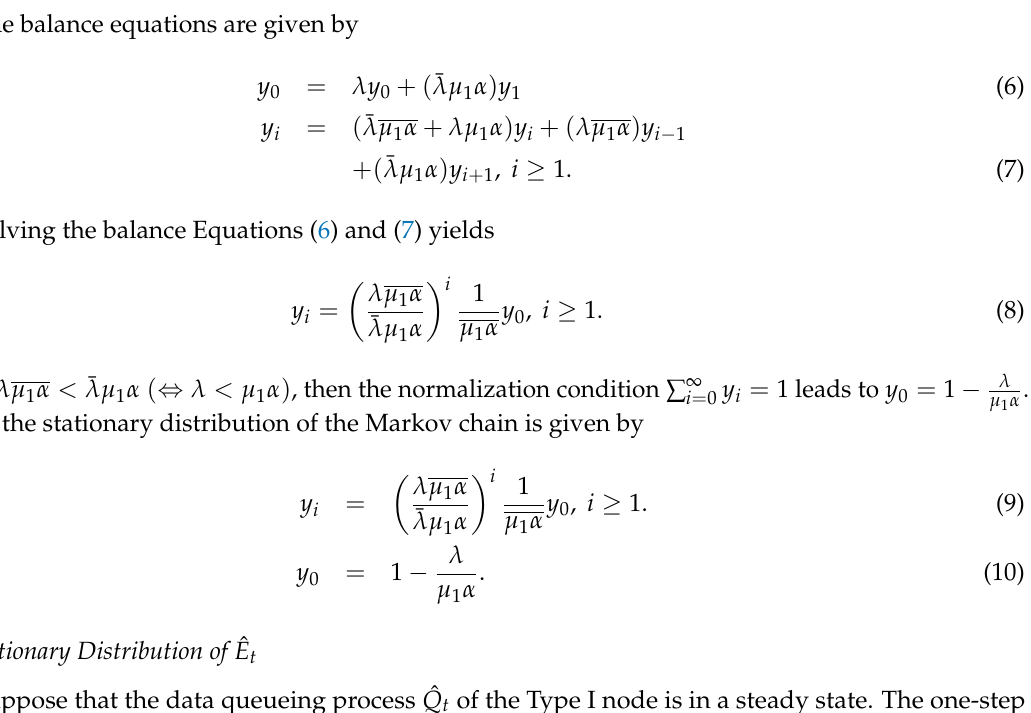
Figure 3. Markov chain model ˆ Q t of the Type I node’s data queue, given that the Type II node’s energy queue ˆ E t is in a steady state. Note that α = 1 − µ 2 P ( ˆ E t ≥ m )